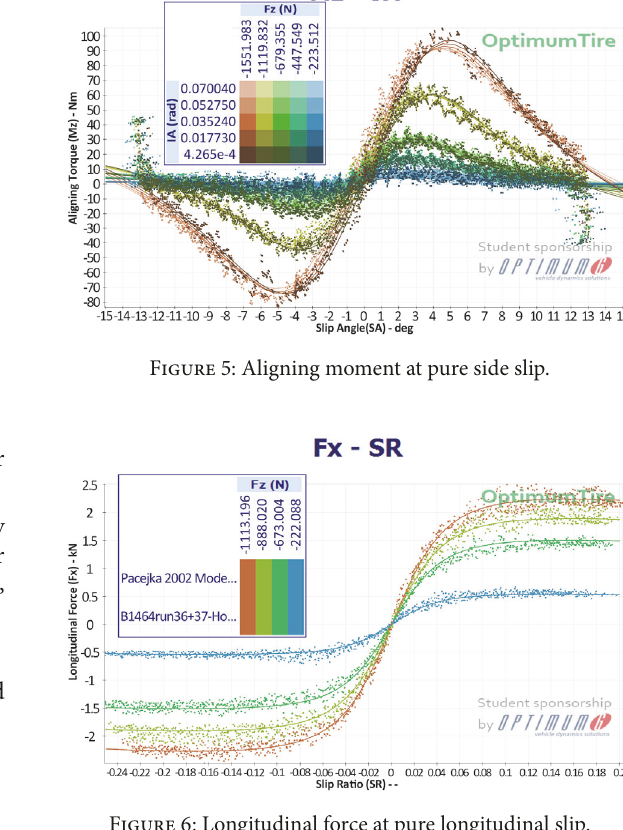
Figure 6: Longitudinal force at pure longitudinal